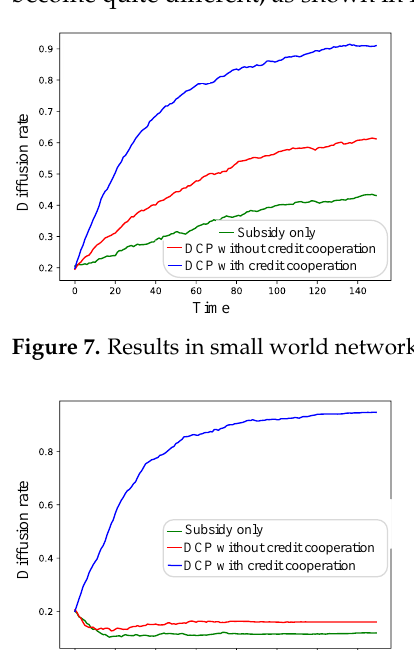
Figure 6. Results in scale free network.